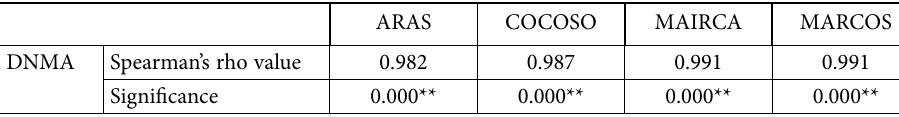
Table 10. Spearman’s rho values of the techniques compared. ARAS COCOSO MAIRCA MARCOS DNMA Spearman’s rho value 0.982 0.987 0.991 0.991 Significance 0.000** 0.000** 0.000**